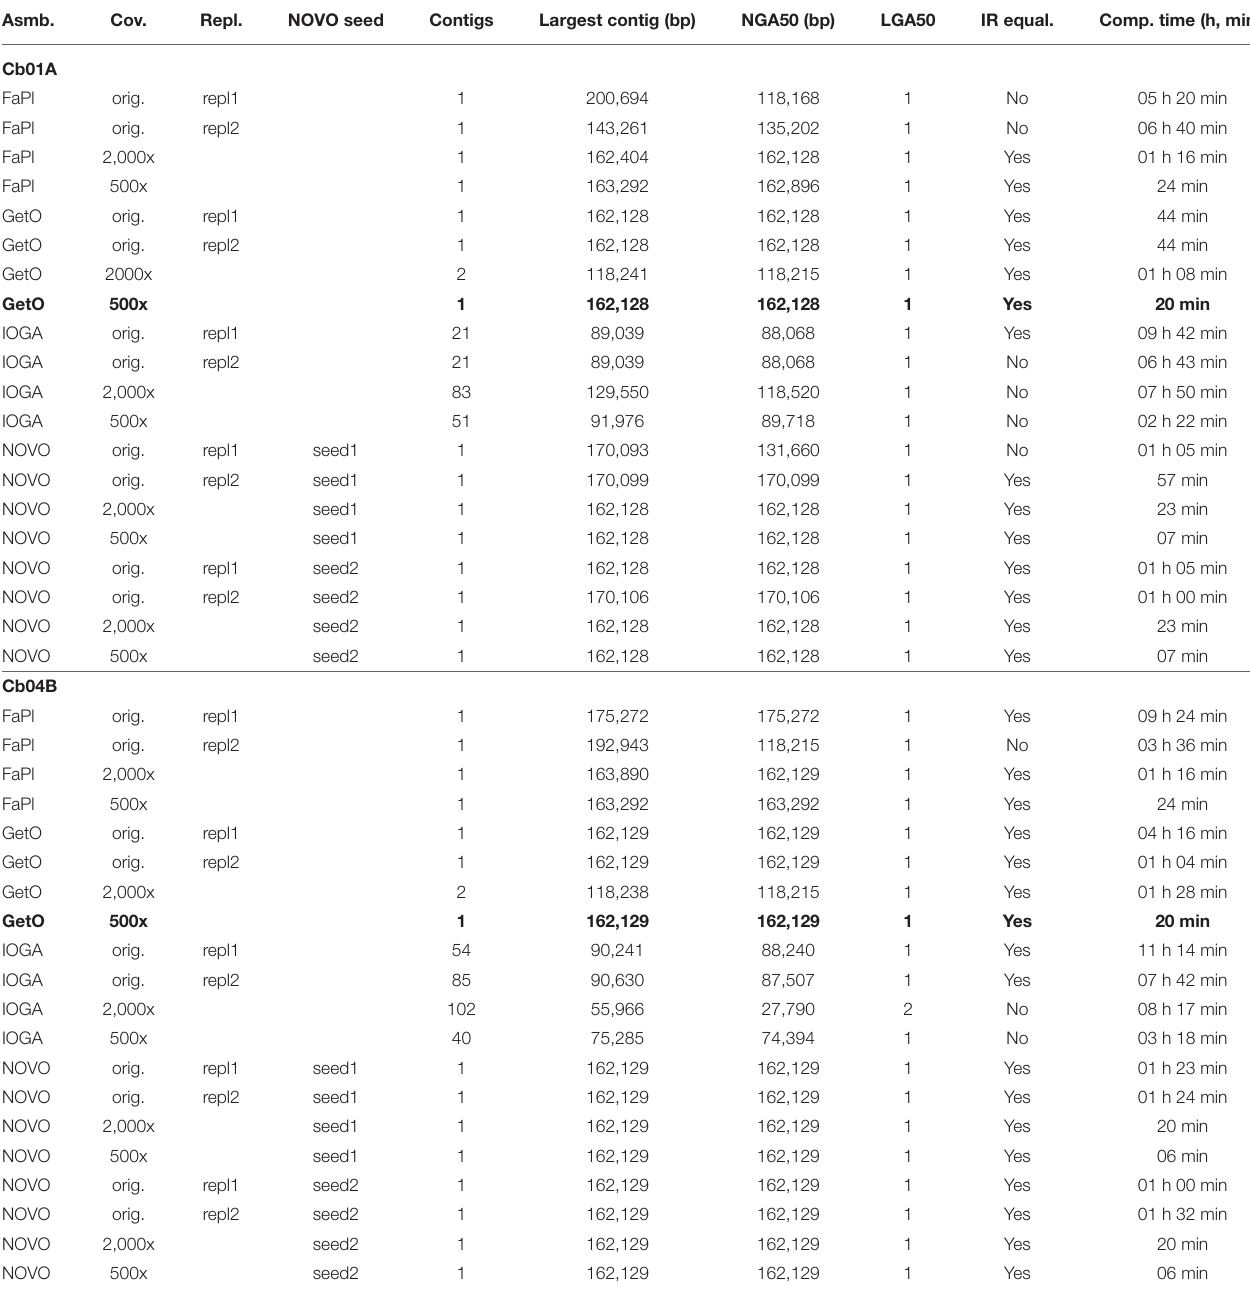
TABLE 1 | Assembly statistics for the plastid genomes of the two individuals of C. bakuense under study regarding the impact of assembly software choice, run replication, and seed selection. Asmb. Comp. time (h,